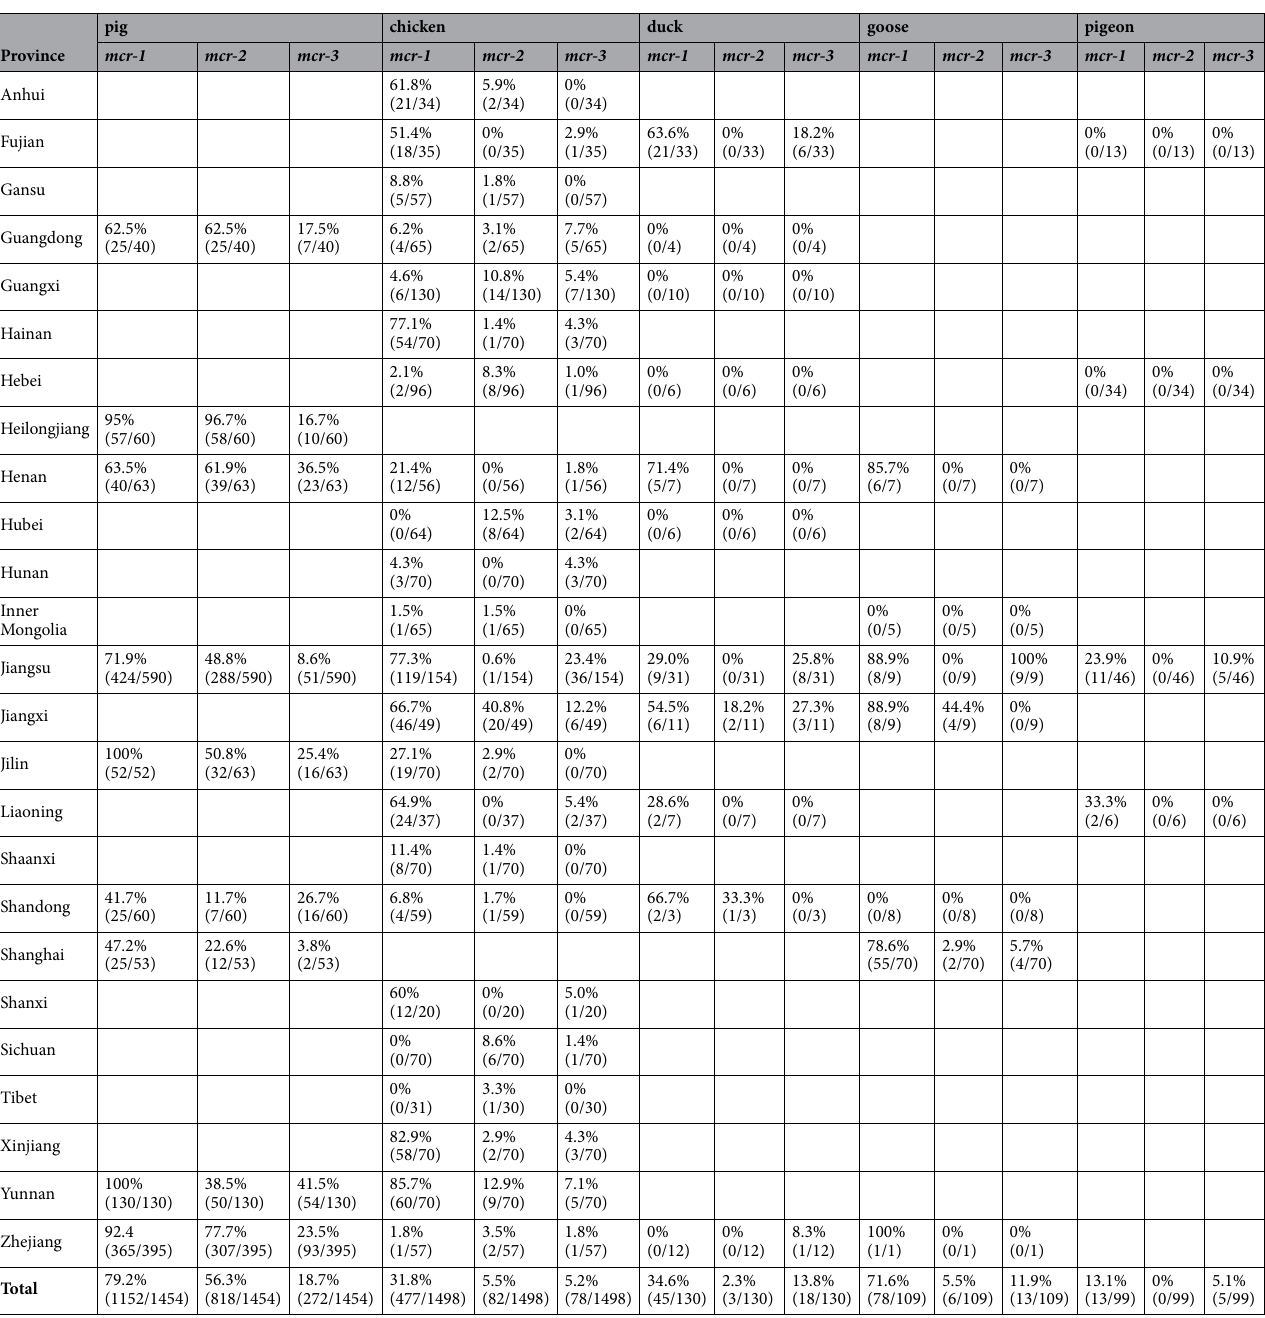
Table 1. Prevalences of mcr-1 , mcr-2 and mcr-3 in samples from pigs and poultry in this